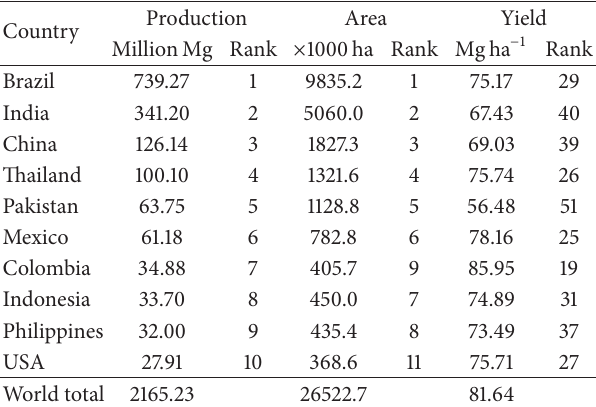
Table 1: The world top 10 sugarcane production countries in 2013 for their cane production, hectarage, and cane yield as well as their ranks in 103 sugarcane production